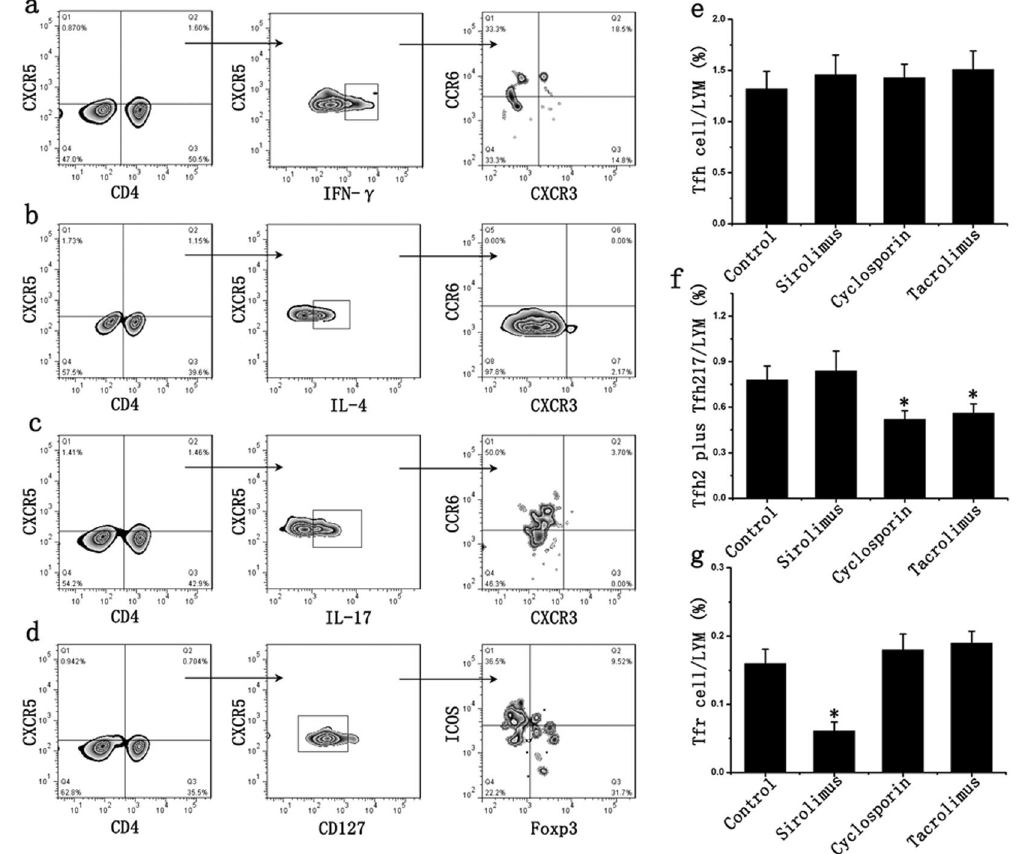
Figure 3. Effects of anti-rejection drugs on Tfh cell subsets. ( a ) CD4, CXCR5, IFN- γ , CXCR3 and CCR6 antibodies were used to detect Tfh1 cells; ( b ) CD4, CXCR5, IL-4, CXCR3 and CCR6 antibodies were used to detect Tfh2 cells; ( c ) CD4, CXCR5, IL-17, CXCR3 and CCR6 antibodies were used to detect Tfh17 cells; ( d ) CD4, CXCR5, ICOS, Foxp3 and CD127 antibodies were used to detect Tfh and Tfr cells; ( e ) The anti-rejection drugs had no significant effect on the proportion of Tfh cells in lymphocytes (LYM). ( f ) Cyclosporine and tacrolimus reduced the proportion of IL-21-producing Tfh cells (Tfh2 and Tfh17 cells) in lymphocytes. ( g ) Sirolimus could reduce the proportion of Tfr cells in lymphocytes after being stimulated for 48 hours. Student’s t test: * p < 0.05 (n = 6) versus Control. Values are mean ±